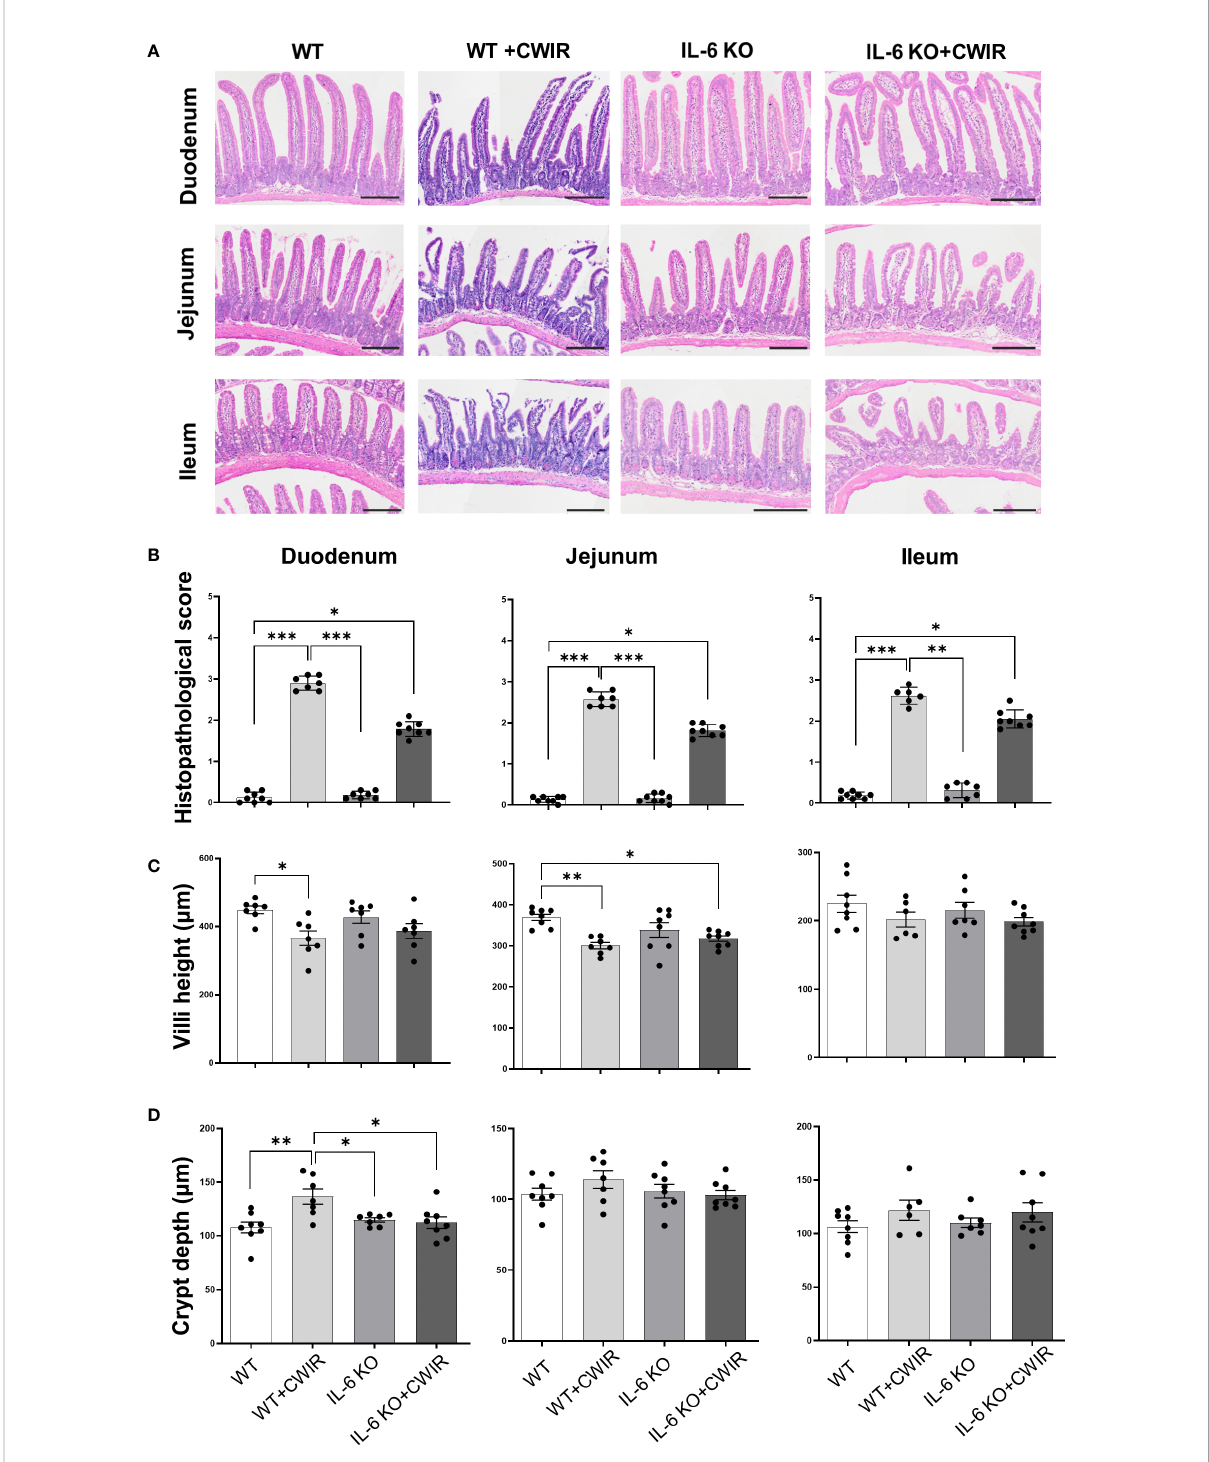
FIGURE 1 Morphological observation of intestinal tissues in IL-6 KO mice administrated with CWIR. (A), Representative images of HE staining of the duodenum, jejunum, and ileum tissues among groups. The scale bar means 200 m m. (B), Histopathological scoring analysis of the groups ’ HE staining images of the duodenum, jejunum, and ileum tissues. Kruskal-Wallis test with Dunn ’ s multiple comparisons was used for data analysis. (C, D) Measured villi height and crypt depth in the small intestinal tissues in the WT and IL-6 mice with CWIR. Data analysis was performed by two-way ANOVA with the Tukey post-hoc test. N=6-8, * p <0.05, ** p <0.01, *** p